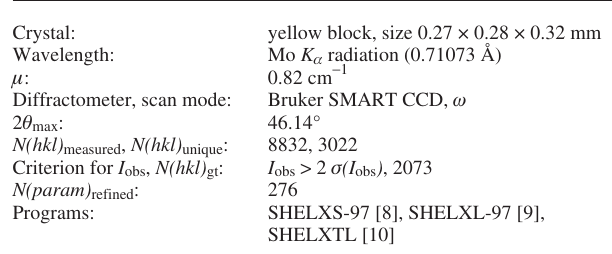
Table 1. Data collection and handling.